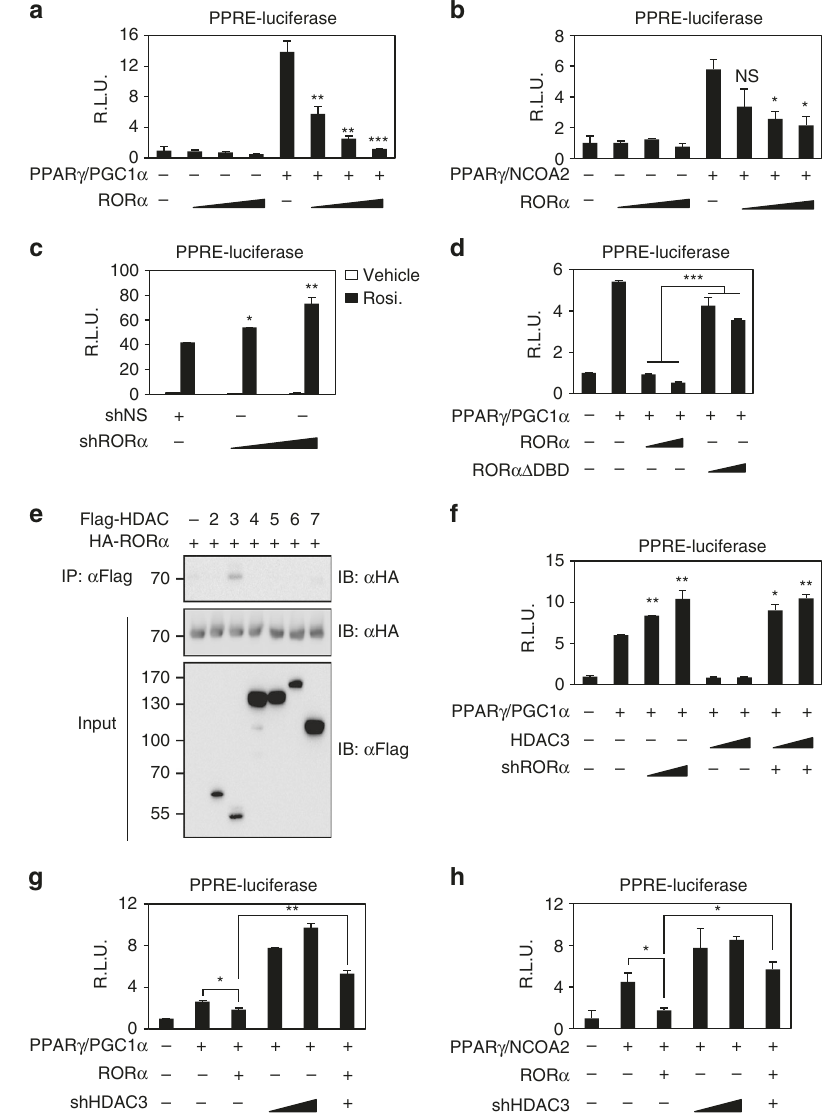
Fig. 4 ROR α interacts with HDAC3 to repress PPAR γ transcriptional activity. a , b Effect of overexpression of ROR α on PPRE-luciferase reporter activity with coactivator PGC1 α a or NCOA2 b . * P < 0.05, ** P < 0.01, *** P < 0.001, NS, non-signi fi cant, compared to PPAR γ /coactivator group. c Effect of knockdown of ROR α on PPRE-luciferase reporter activity. Cells were treated with DMSO (vehicle), rosiglitazone (20 μ M) for 24 h. * P < 0.05, ** P < 0.01, compared to shNS group. d Effect of ROR α Δ DBD mutant on PPRE-luciferase reporter activity. *** P < 0.001. e Co-immunoprecipitation assay was performed to detect the interaction between ROR α and HDACs of HEK293T cells. f Effect of ROR α on PPRE-luciferase reporter activity by HDAC3 overexpression. * P < 0.05, ** P < 0.01, compared to PPAR γ /PGC1 α group. g , h Effect of knockdown of HDAC3 with coactivator PGC1 α g and NCOA2 h on PPRE-luciferase reporter activity. Data expressed as mean ± s.e.m. Statistical analysis was performed using one-way ANOVA followed by Tukey ’ s post hoc analysis. * P < 0.05, ** P < 0.01. Data expressed as mean ±